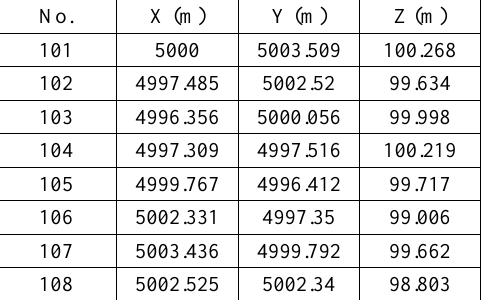
Figure 5. Ten laser scanning